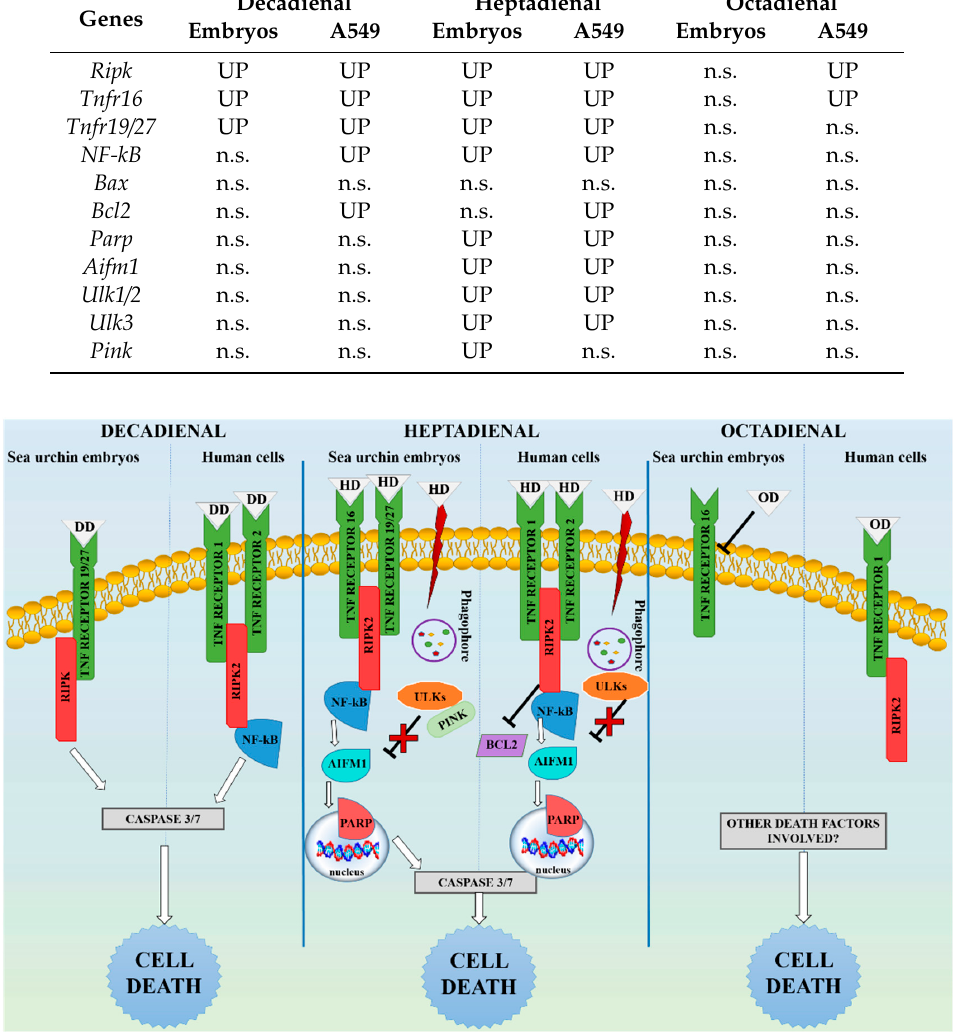
Figure 4. Schematic representation of death genes activated in the sea urchin Paracentrotus lividus embryos and A549 human cells. All genes studied by qPCR and significantly upregulated or downregulated by PUAs are represented with a specific colour, whereas caspase 3/7 (represented in a grey rectangle) was already investigated in a previous study [23] and was used in this figure only to complete the pathway. Phagophores engulf cytoplasmic components during autophagy that are delivered to lysosomes for degradation. “DD” refers to decadienal, “HD” refers to heptadienal, and “OD” refers to octadienal.